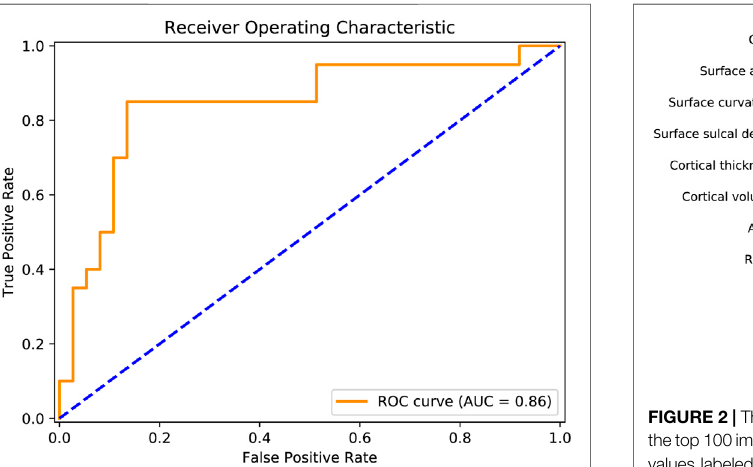
FIGURE 1 | Prediction performance was quanti fi ed using the receiver operating characteristic curve. The orange solid line re fl ected actual classi fi cation results, and the blue dashed line indicated the chance level.